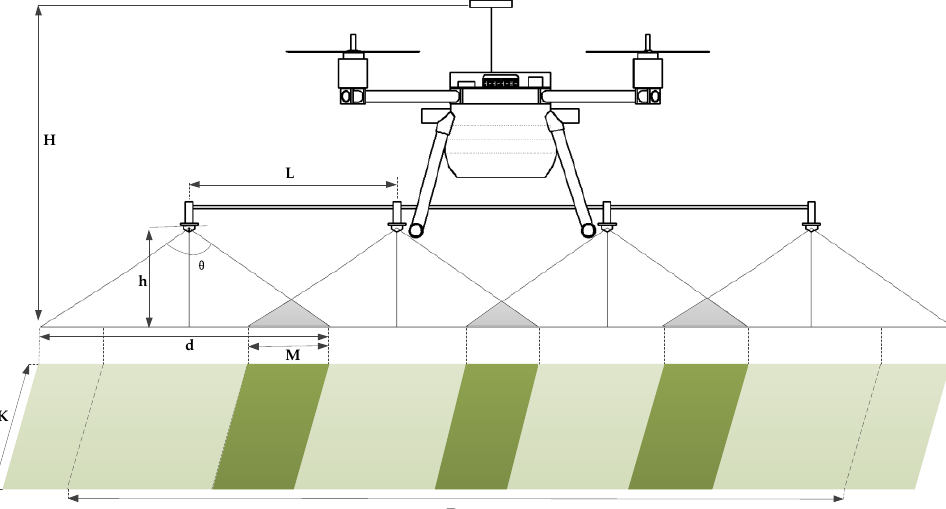
Figure 9. Schematic diagram of nozzle installation. Note: H is the height of the GPS from the top of the crop in me; h is the height of the nozzle from the top of the crop in m; L is the installation distance of the adjacent nozzle in m; d is the spray nozzle of the corresponding height in m; M is the width of the overlap area of the adjacent nozzles in m; K is a certain time, with the distance of the drone flight in m; D is the effective spray width of the drone in m.